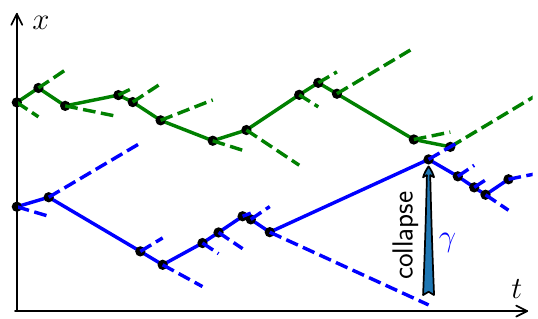
Figure 1: Illustration of the collapsed quasiparticle pairs Ansatz describing the en- tanglement dynamics of a free fermion chain under continuous measurement of local occupation numbers with rage γ . The initial state ( t = 0) is a product state, described by pairs of localized quasiparticle pairs with opposite velocities (only two pairs are depicted). A quasiparticle travels ballistically and independently, until it is collapsed by the measurement (this happens at rate γ for each quasiparticle, independently of others). When that happens, a new pair is created at the position of its partner, with velocity v = ± v ( k ) where k is a randomly chosen momentum (uniform in [ − π , π ) ) and v ( k ) is its group velocity. See Sections 4 and 5 for further